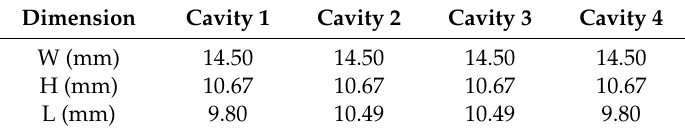
Table 1. Parameters of each cavity width (W), height (H), and length (L).